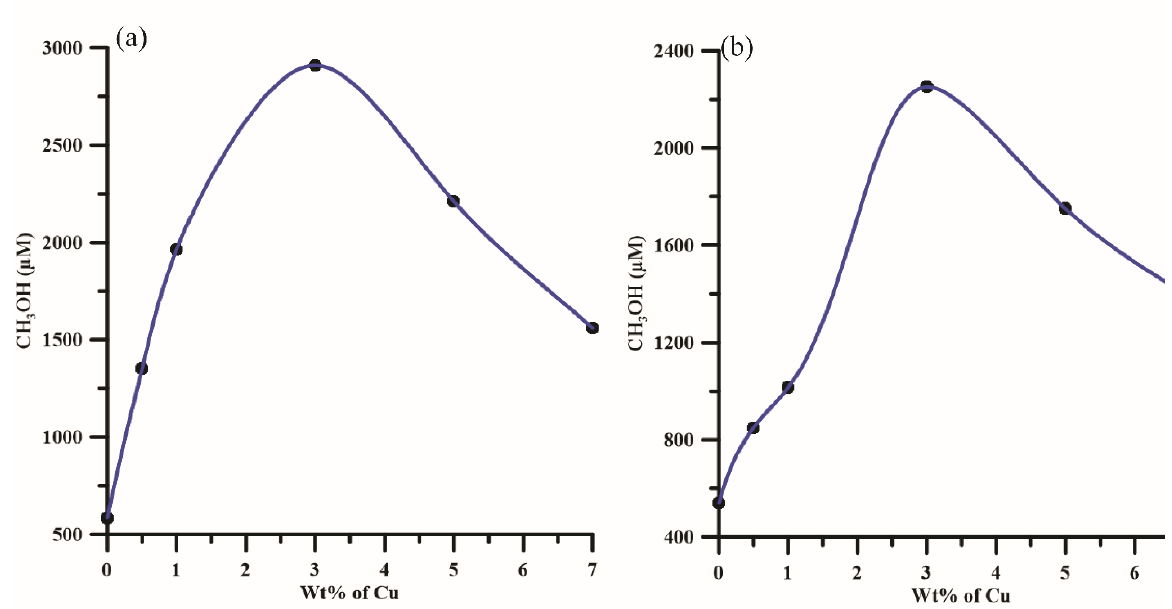
Figure 5: The effect of Cu loading on methanol yield after 5 h irradiation of UV (a); PSW-1, (b); PSW-2